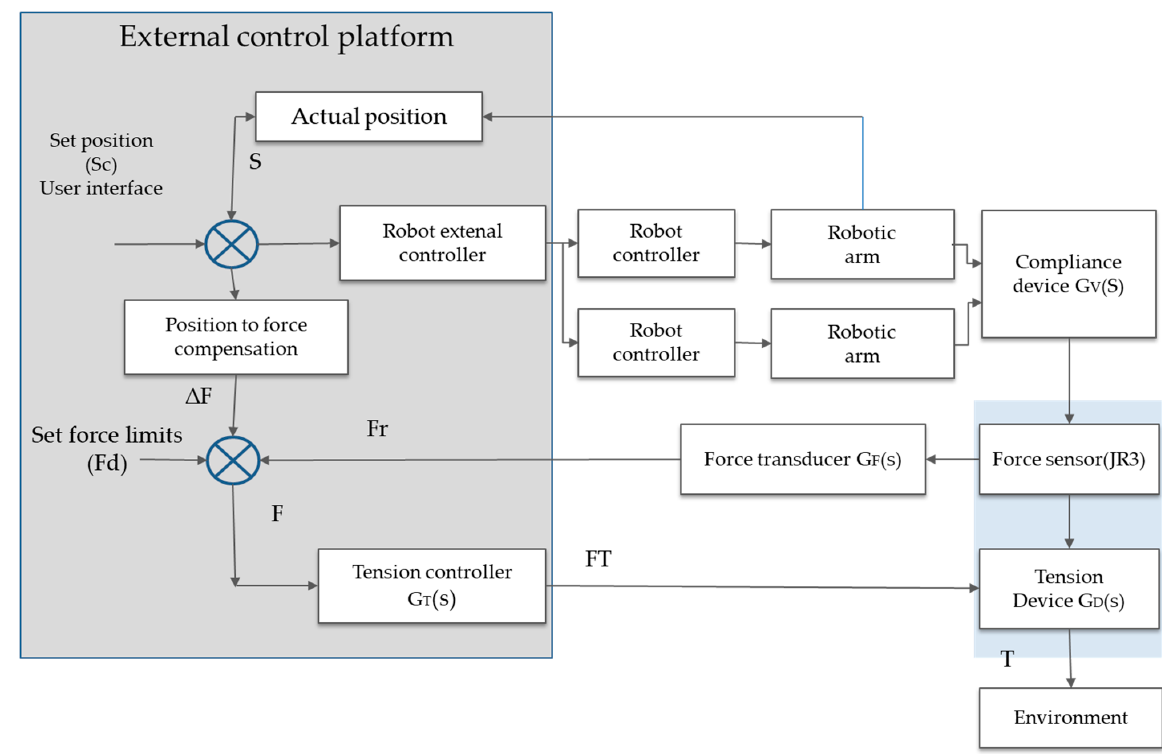
Figure 2. Software and hardware control system of the tensioning.